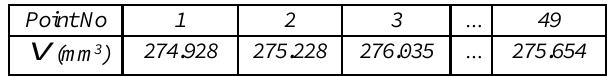
Table 1. The volume of point error space